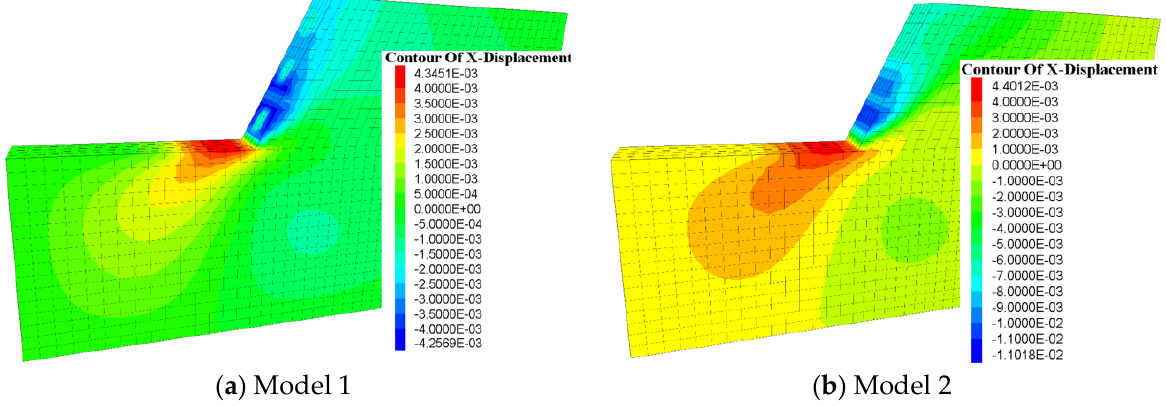
Figure 11. Comparison of horizontal displacements after the third excavation (unit: m).